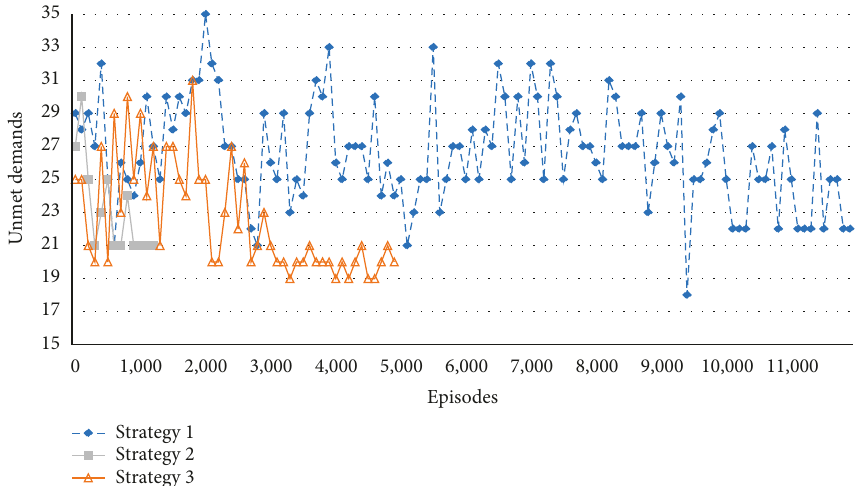
Figure 7: Performance analysis in deterministic demand contexts.